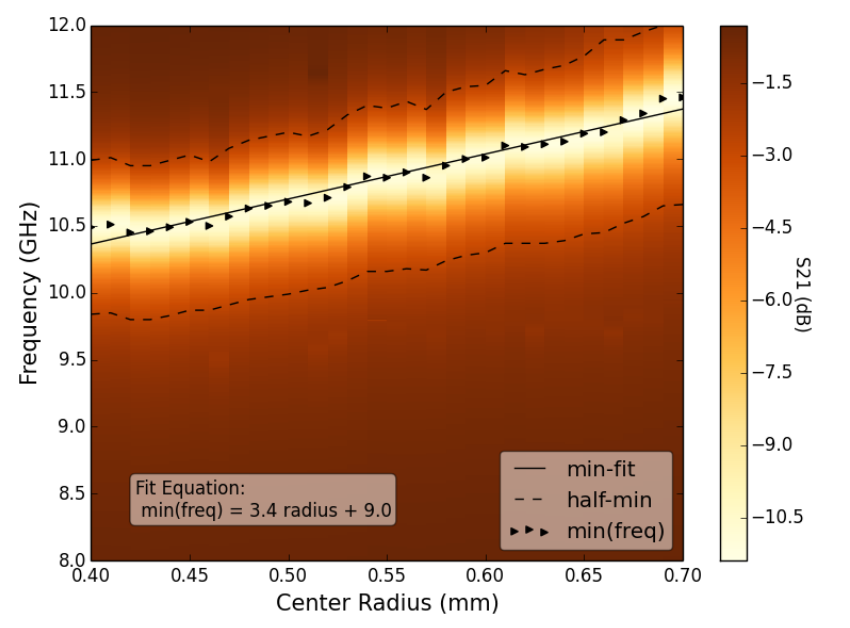
Figure A12. Simulated S 21 RF Response of Spirals with Varying Center Radii. Color indicates S 21 in dB, triangles indicate the minimum points and dashed lines indicates half of the minimum